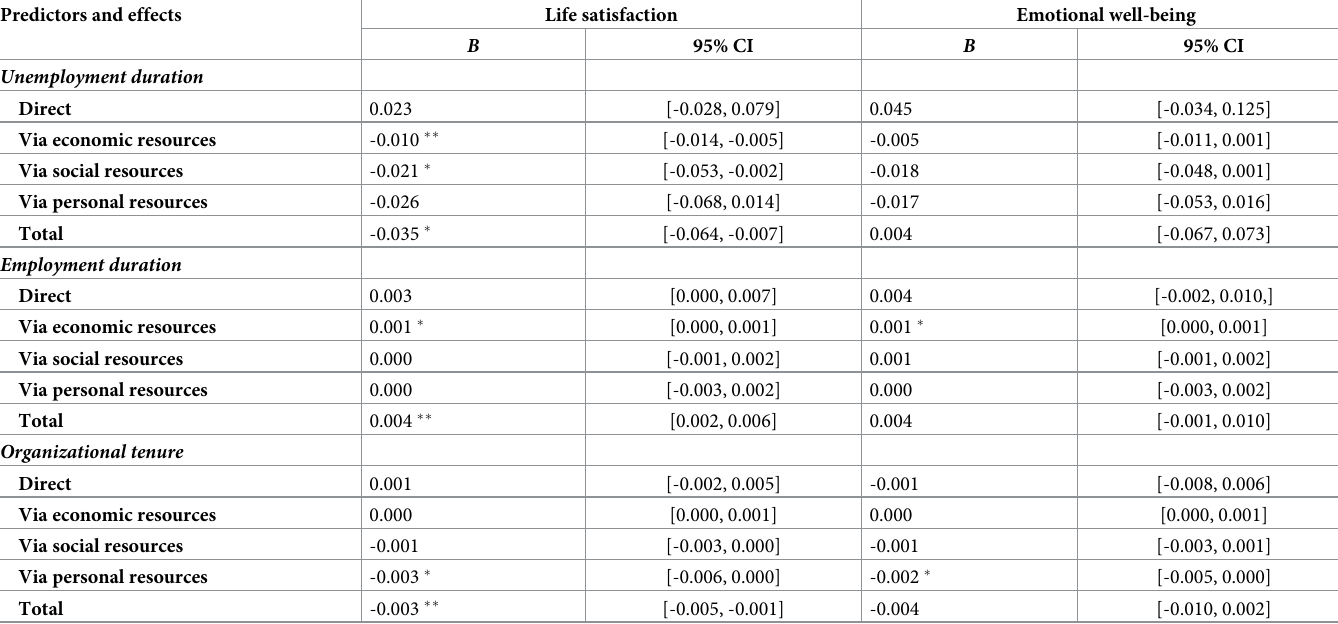
Table 5. Summary of direct, indirect, and total within-level effects of employment status duration on SWB. Predictors and